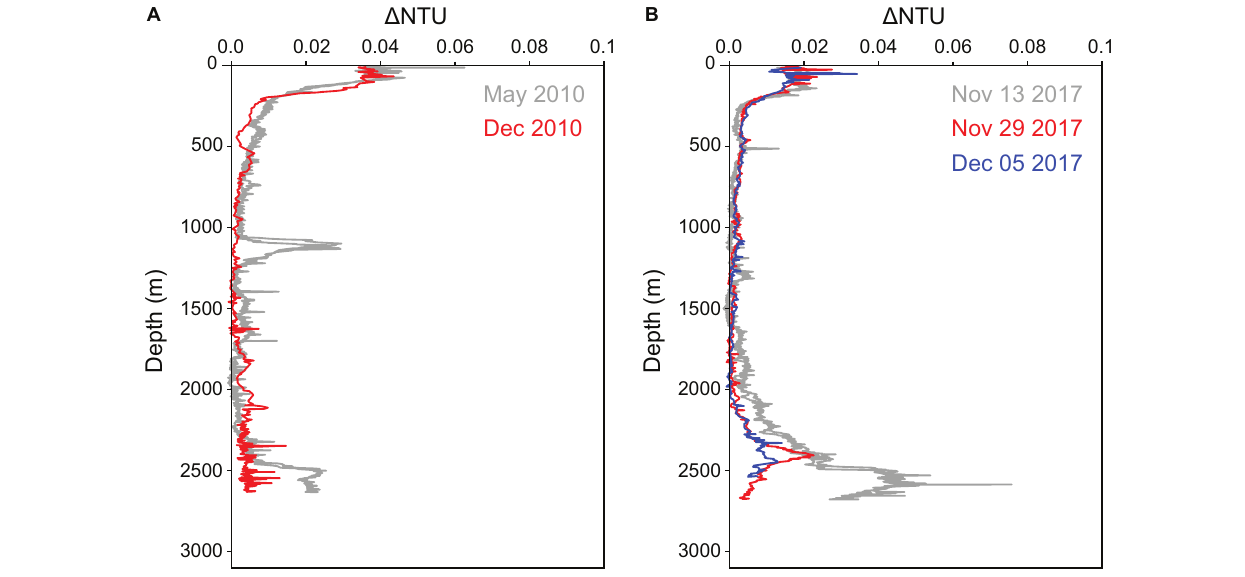
near the eruptive vents, and the deeper volcaniclastic deposits (up to ∼ 30 m thick) were consistent with eruptive products moving further down the steep slopes by gravity (Chadwick et al.,